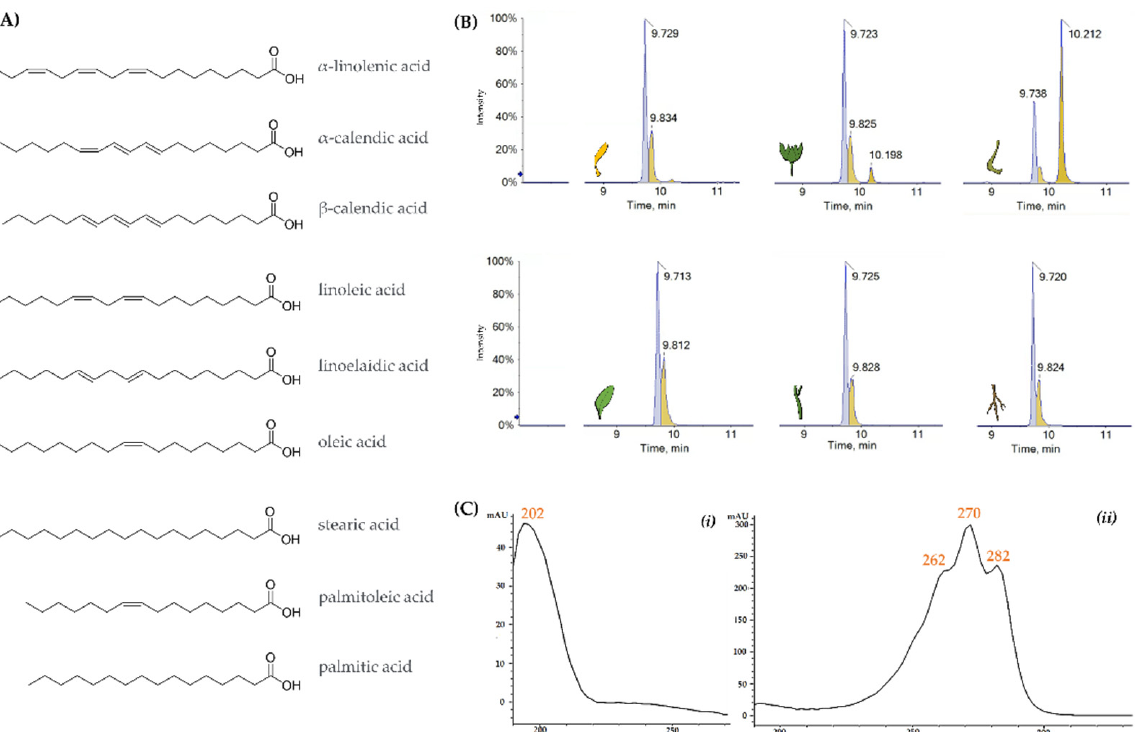
Figure 2. ( A ) Chemical structures of FAs tentatively identified in the extracts of Calendula arvensis organs. ( B ) Extracted Ion Chromatograms (XICs) of the ions at m / z 277.2177 ± 0.05 in the extract of: florets, bracts, fruits, leaves, stems, and roots. ( C ) UV spectra of ( i ) compound 15 , ( ii ) compounds 16 and 17 .